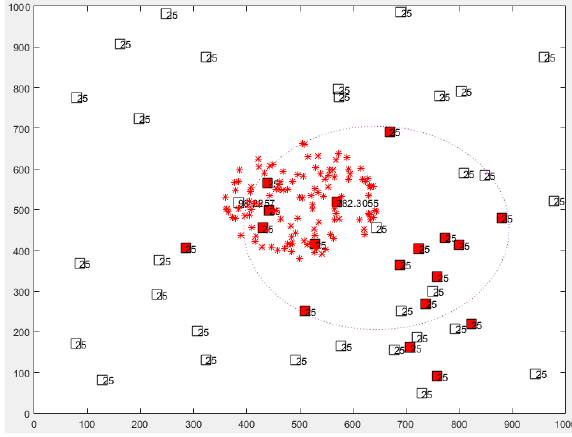
Fig. 2. The simulation